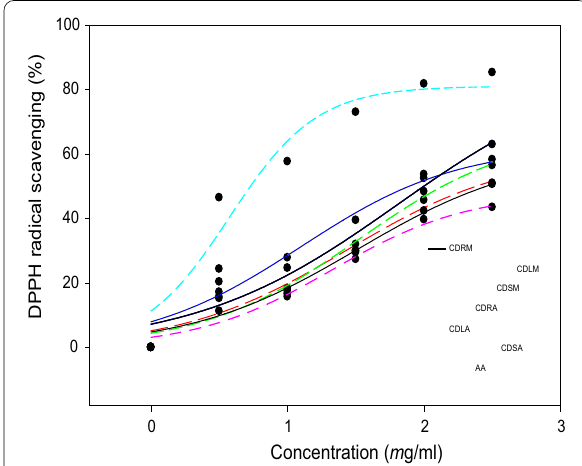
Fig. 2 Effects of crude aqueous and methanol extracts of leaves, stem and roots of C. dependens and ascorbic acid (AA) on